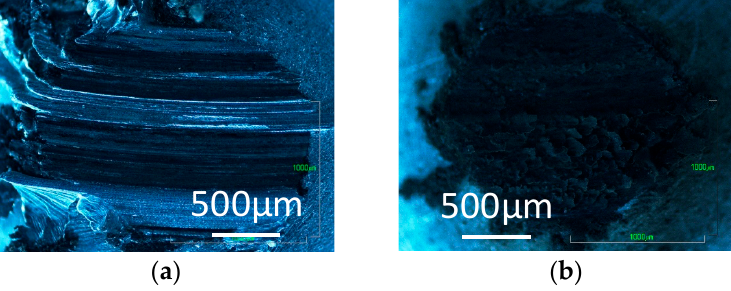
Figure 10. Photographs of aluminum pins slid against ta-C DLC in argon; with ( a ) 0 ppm water; and ( b ) 120 ppm water.